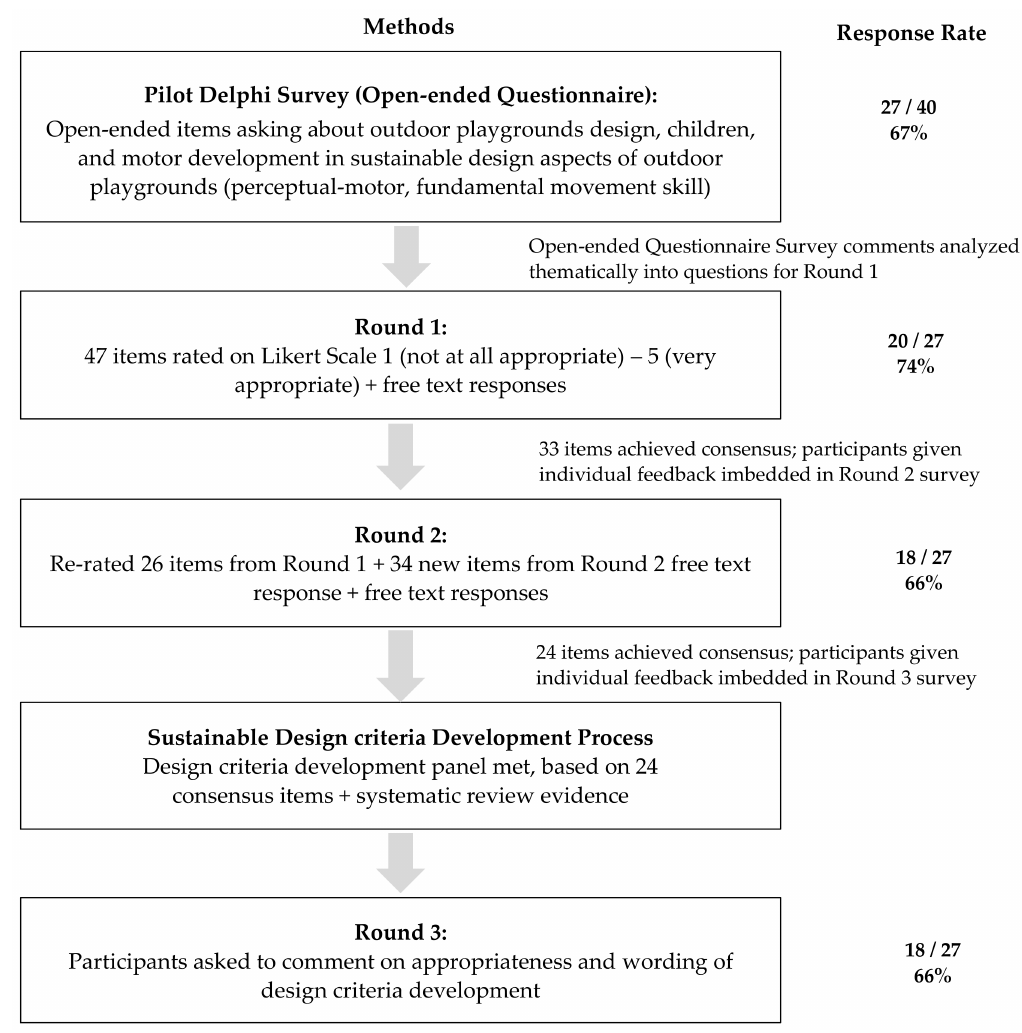
Figure 1. Steps of the Delphi study